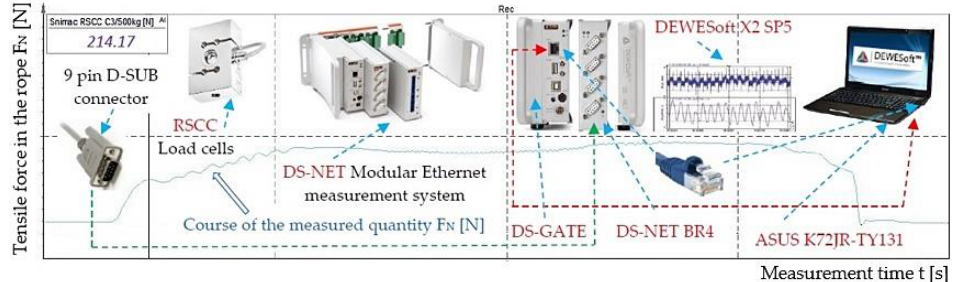
Figure 9. Time course of the measured tractive force F N on the advancing side of the cable on the pulley of the laboratory device.